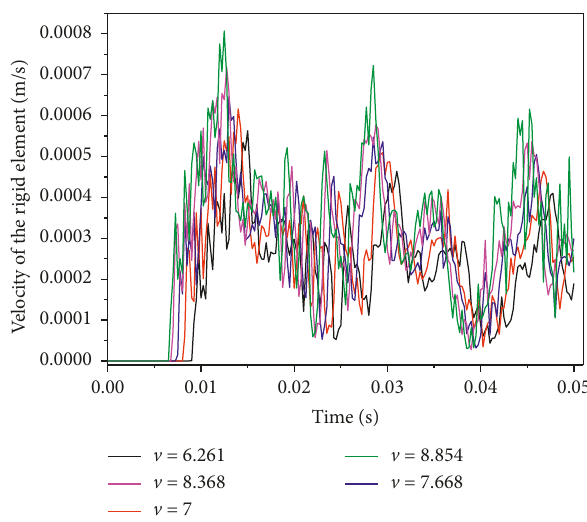
Figure 19: Velocity of the tail beam.